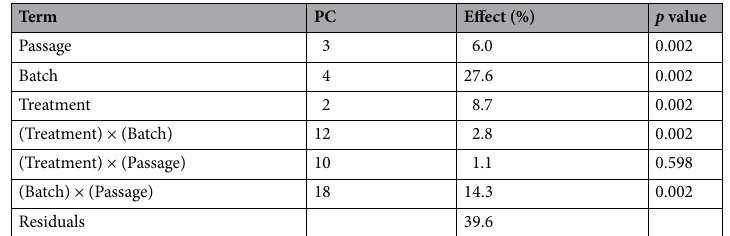
Table 1. Relative contributions of the effect of processing batch, cellular passage and drug treatment and their interaction to the total variation estimated by ASCA. * p values were estimated using 500 permutations. Effects were considered significant when the p value <